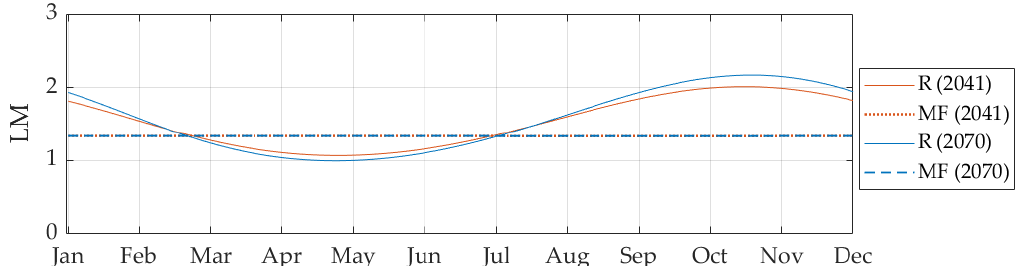
Figure 7. Lifetime Multiplier (LM) associated to the expected climate in Private in 2041 (orange) and 2070 (blue) in the room (R, solid lines) and inside the microclimate frame (MF, dotted/dashed